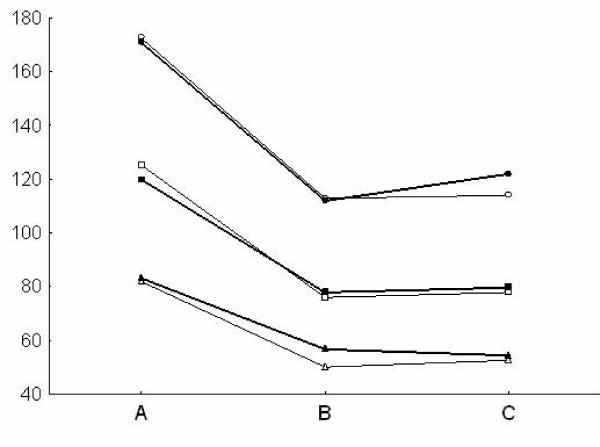
Middle Cerebral Artery: Mean of PSV (circle), TAMM (square) EDV (triangle) in TCD (narrow line) e TCCS (thick line) in the three groups of patients A, B, C.